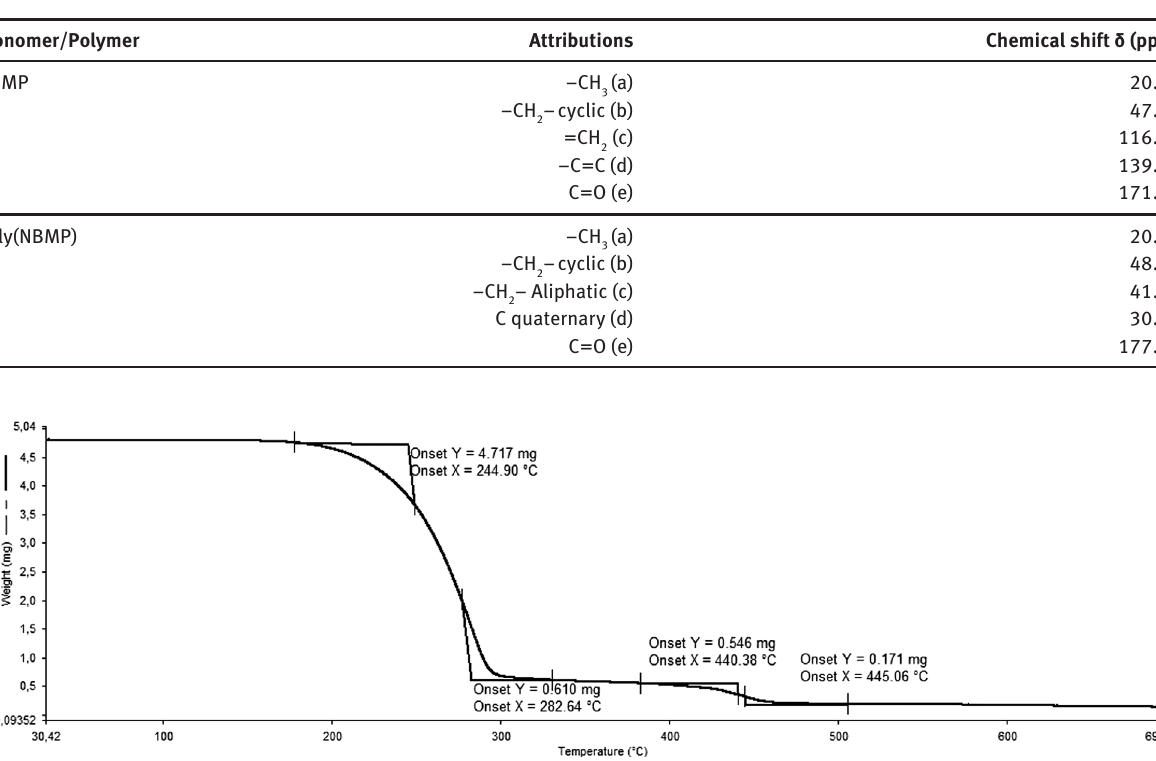
Table 1: 13 C NMR chemical shift for various carbons of NBMP and